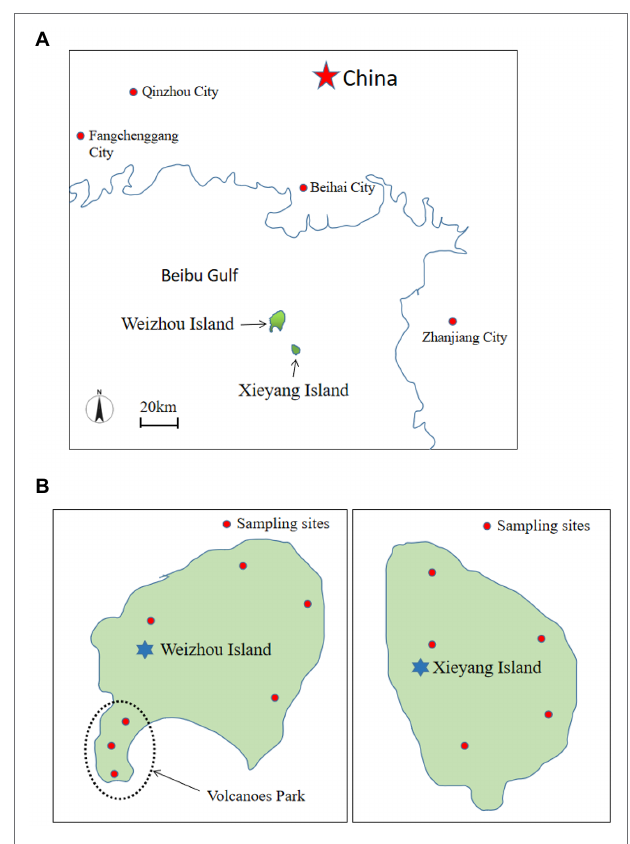
FIGURE 1 | Geographical location of Weizhou and Xieyang Island (A) and sampling sites of both islands from which samples were collected (B)